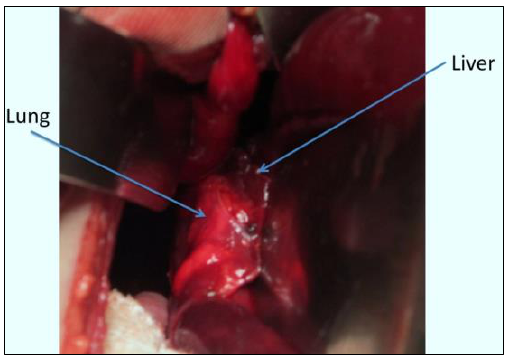
Figure 1: Showing right CDH, and mediastinal shift. The patient was intubated and put on oscillatory mechanical ventilation; dobutamine and dopamine were also started. After initial stabilization, the pa- tient underwent repair of right CDH via a right su-